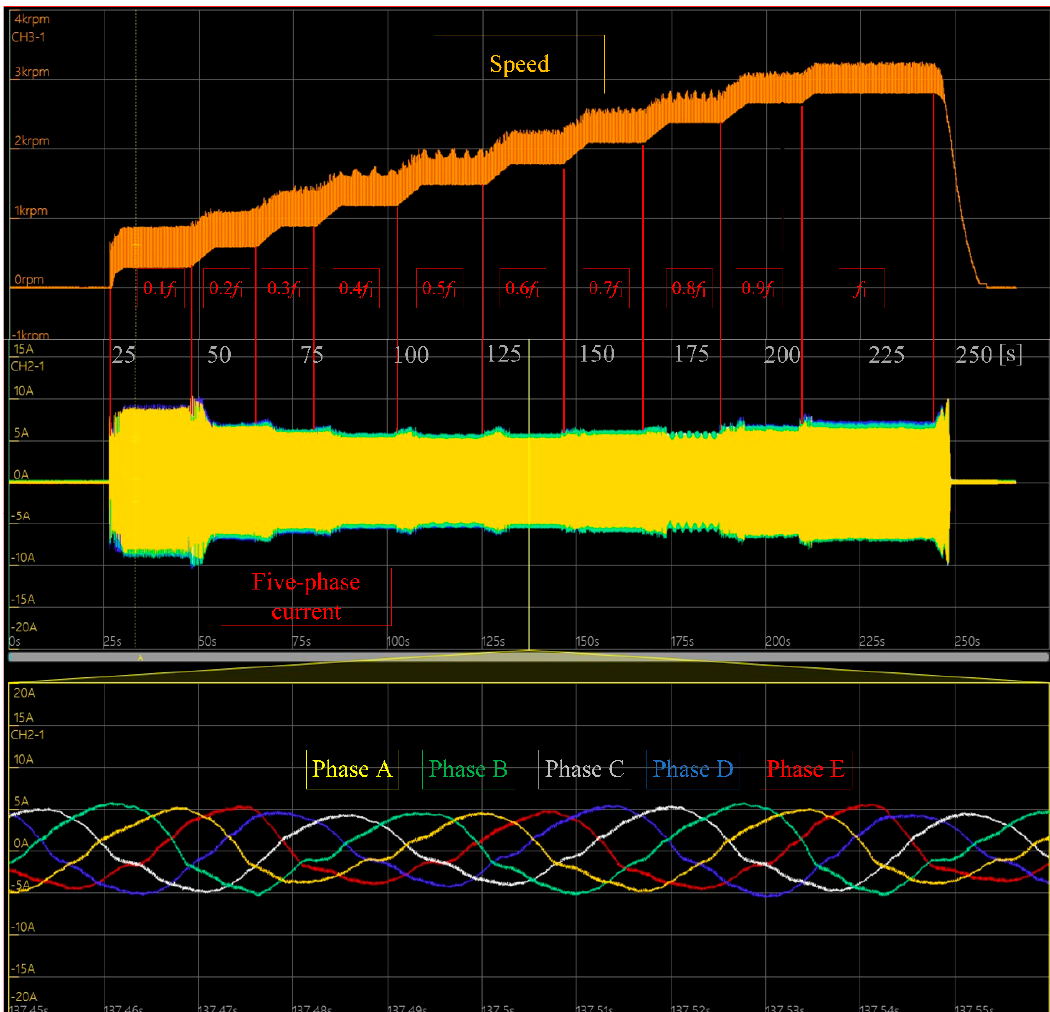
Figure 5. Five − phase current and speed curves from start − up to steady-state.